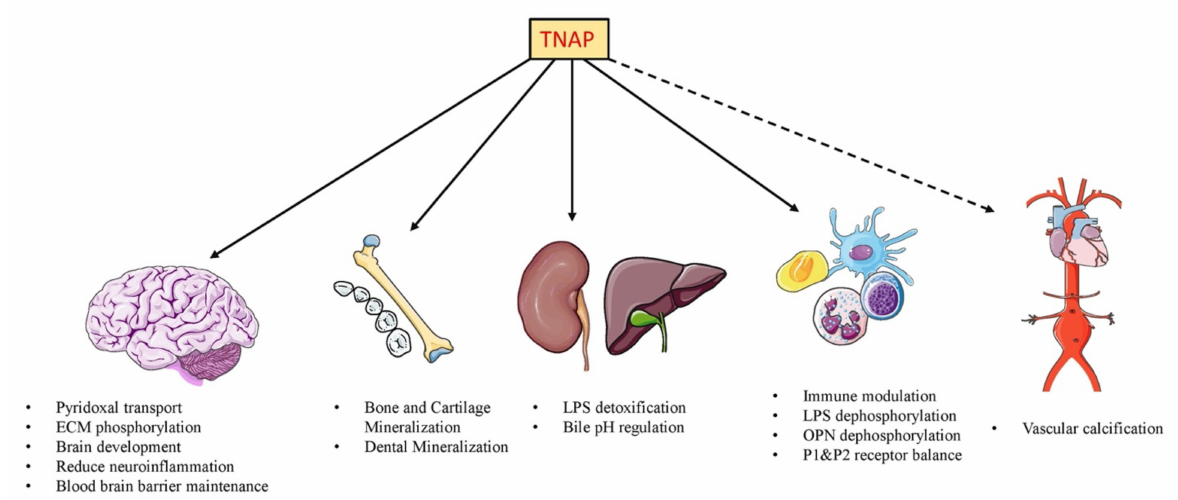
Figure 5. Diagrammatic representation of the central role of TNAP in our body exhibiting mineralization and non- mineralization functions. Dotted arrow indicates its pathological role. The components in this figure were modified from Servier Medical Art, licensed under a Creative Common Attribution 3.0 Generic License (http://smart.servier.com, accessed on 1 August